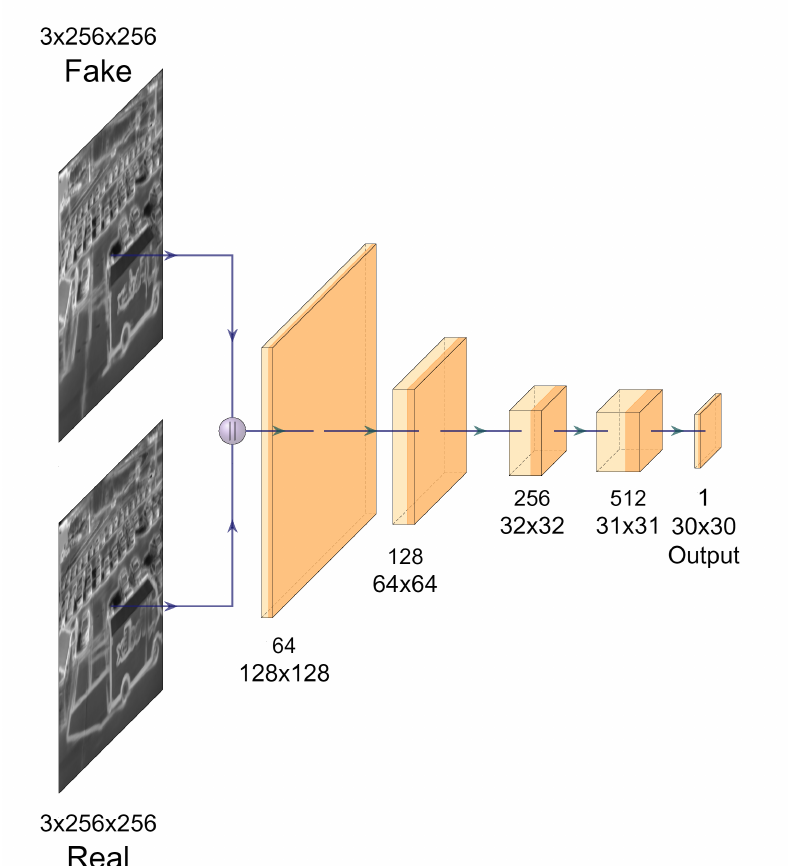
Figure 3. The proposed discriminator structure, which is used for both